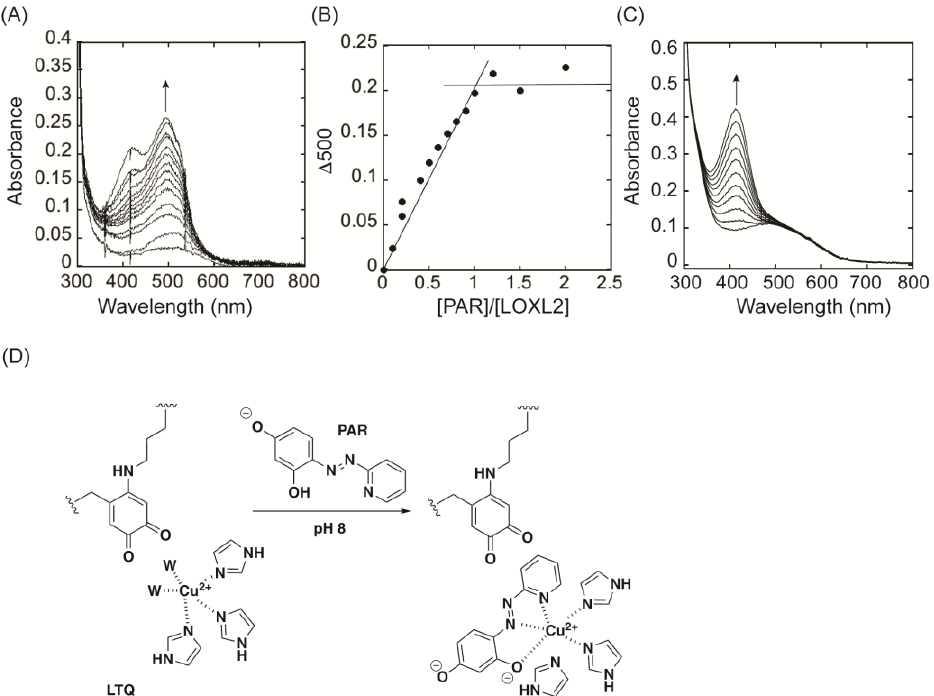
Figure 8. UV − vis spectroscopic titration of LOXL2 and AGAO with PAR. ( A ) UV − vis spectral changes observed upon titration of LOXL2 with substoichiometric amount (0.1 equivalent) of PAR. ( B ) Absorbance change at 500 nm ( Δ500) was plotted against the molar ratio of [PAR]/[LOXL2]. The increase in absorbance at 500 nm saturates at [PAR]/[LOXL2] = 1.0. ( C ) A constant increase at 413 nm (free PAR) was observed but no increase in absorbance at 500 nm was observed upon titration of WT − AGAO with sub-stoichiometric amount (0.1 equivalent) of PAR. ( D ) Ligation of PAR to the